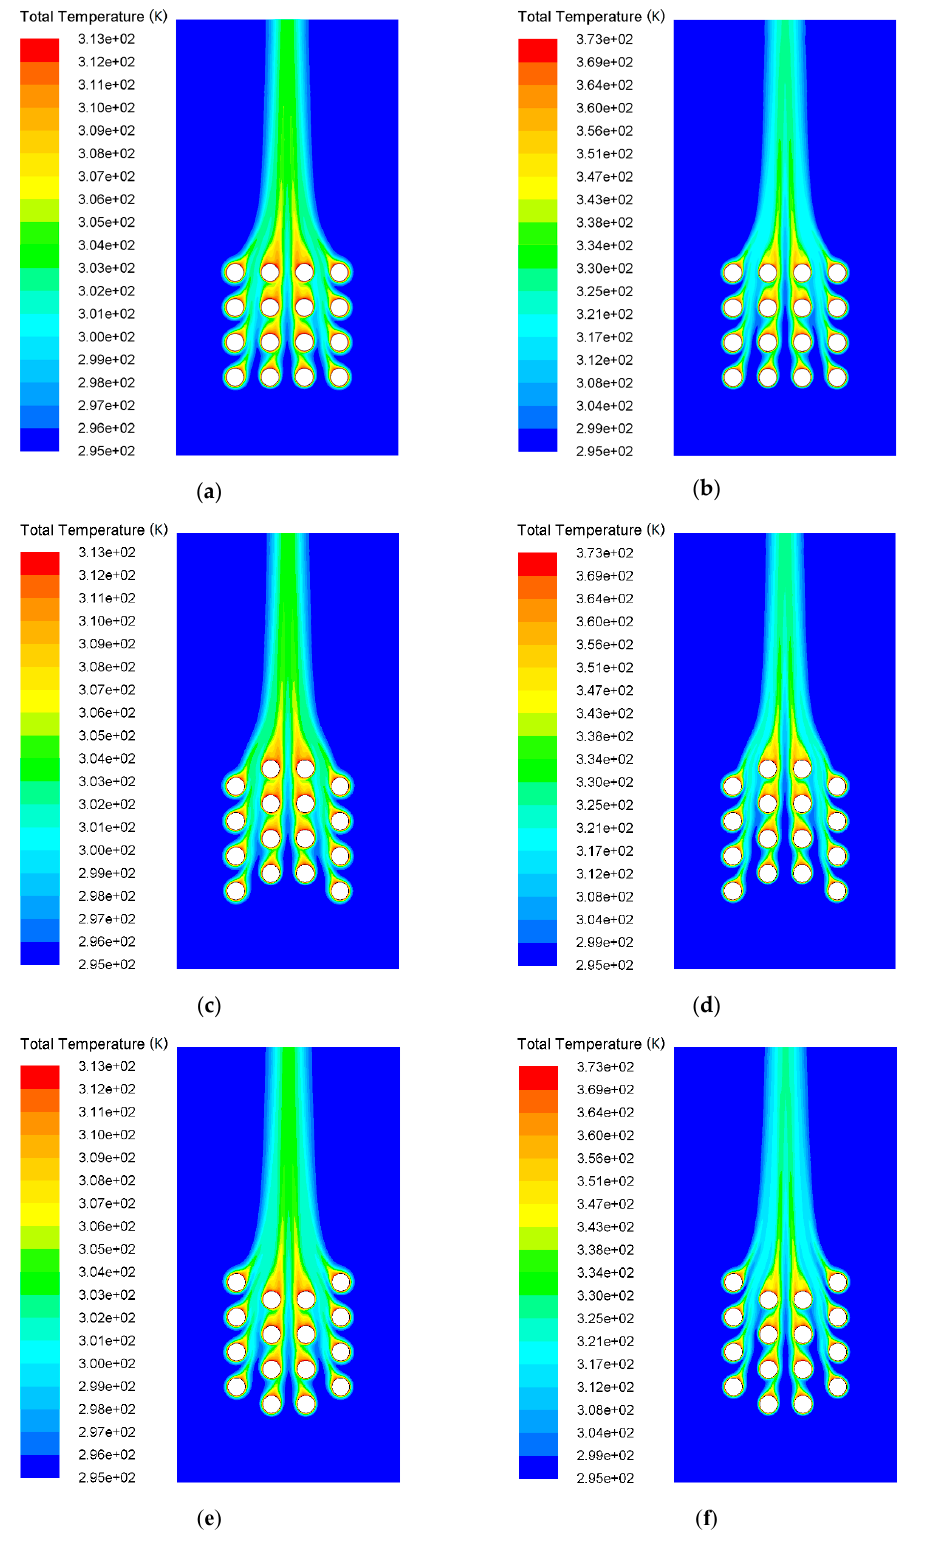
Figure 14. The temperature fields of the tube arrays 4 × 4 with the tube ratio spacing S / D = 2: ( a ) base configuration at Ra = 1.3 × 10 4 ; ( b ) base configuration at Ra = 3.7 × 10 4 ; ( c ) concave configuration at Ra = 1.3 × 10 4 ; ( d ) concave configuration at Ra = 3.7 × 10 4 ; ( e ) convex configuration at Ra = 1.3 × 10 4 ; ( f ) convex configuration at Ra = 3.7 × 10 4